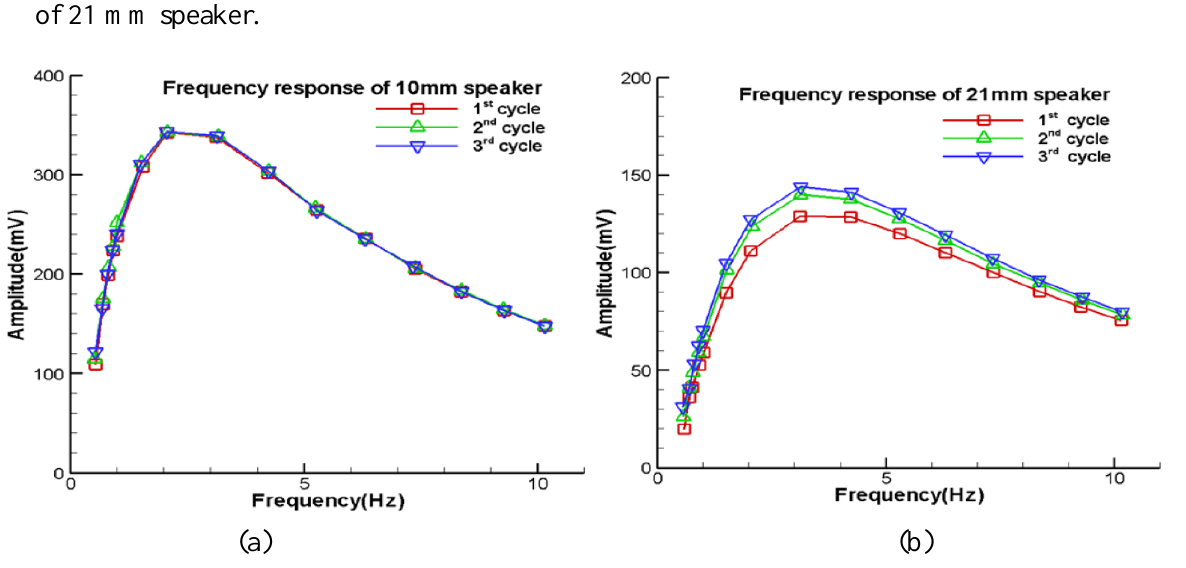
Figure 3. (a) Low frequency response of 10 mm speaker. (b) Low frequency response of 21 mm